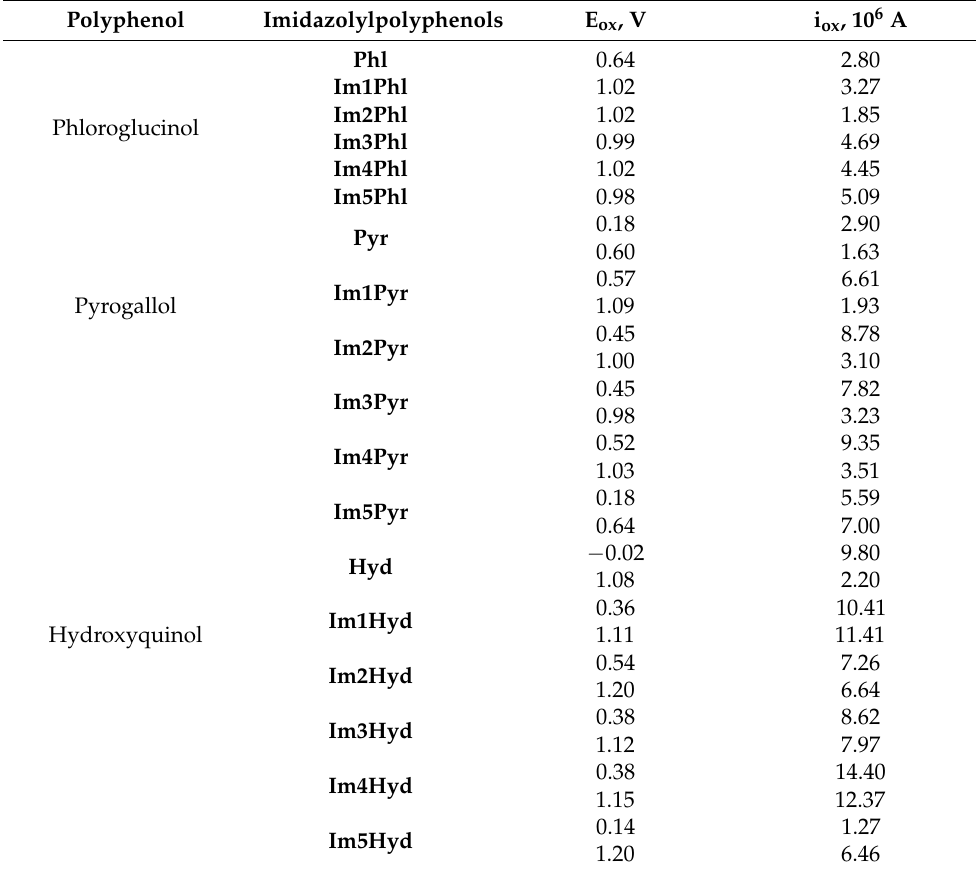
Figure 6. Cyclic voltammograms of hydroxyquinol and imidazolylhydroxyquinols recorded on the glassy carbon electrode (C = 1 mmol/dm 3 ; background: 0.1 mol/dm 3 KCl; scan rate 0.1 V/s). Oxidation potentials of phenols and imidazolylpolyphenols and values of the current for oxidation peaks are presented in Table 2. Table 2. Potentials and currents of oxidation peaks for phenols and imidazolylpolyphenols. Polyphenol